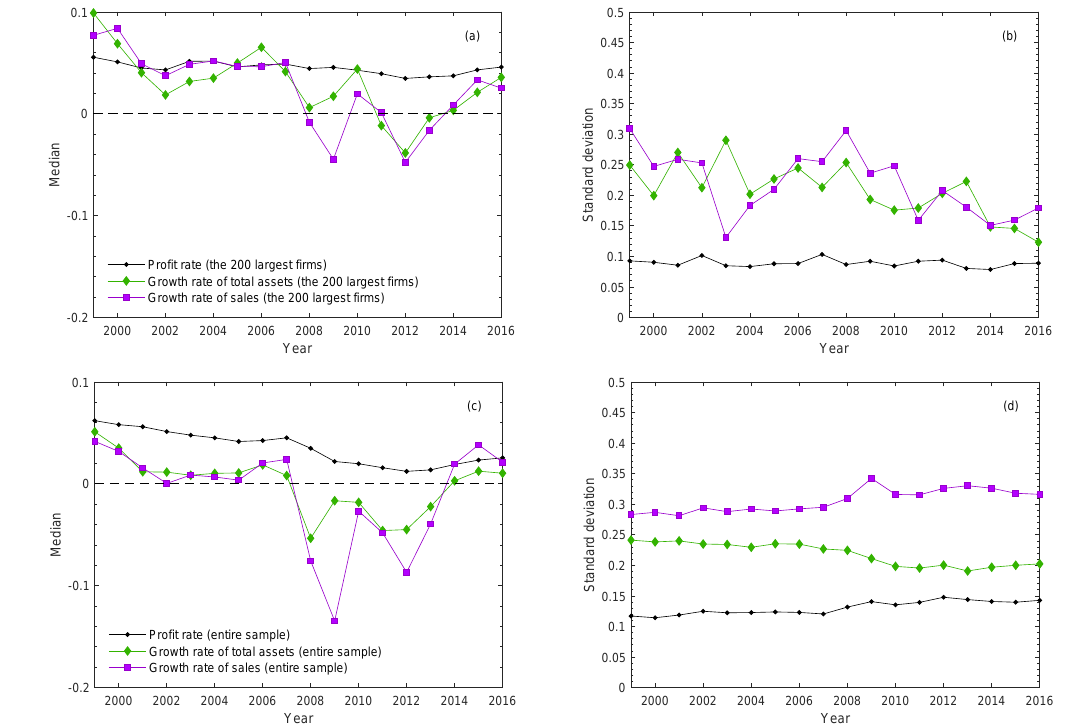
Figure 1. ( a , b ) The evolution of the cross-sectional median and standard deviation of growth ( ˜ g ) and profit rates for the 200 largest long-lived firms, respectively (base year 2016). ( c , d ) The evolution of the cross-sectional median and standard deviation of growth ( ˜ g ) and profit rates for the entire sample at our disposal, respectively (base year